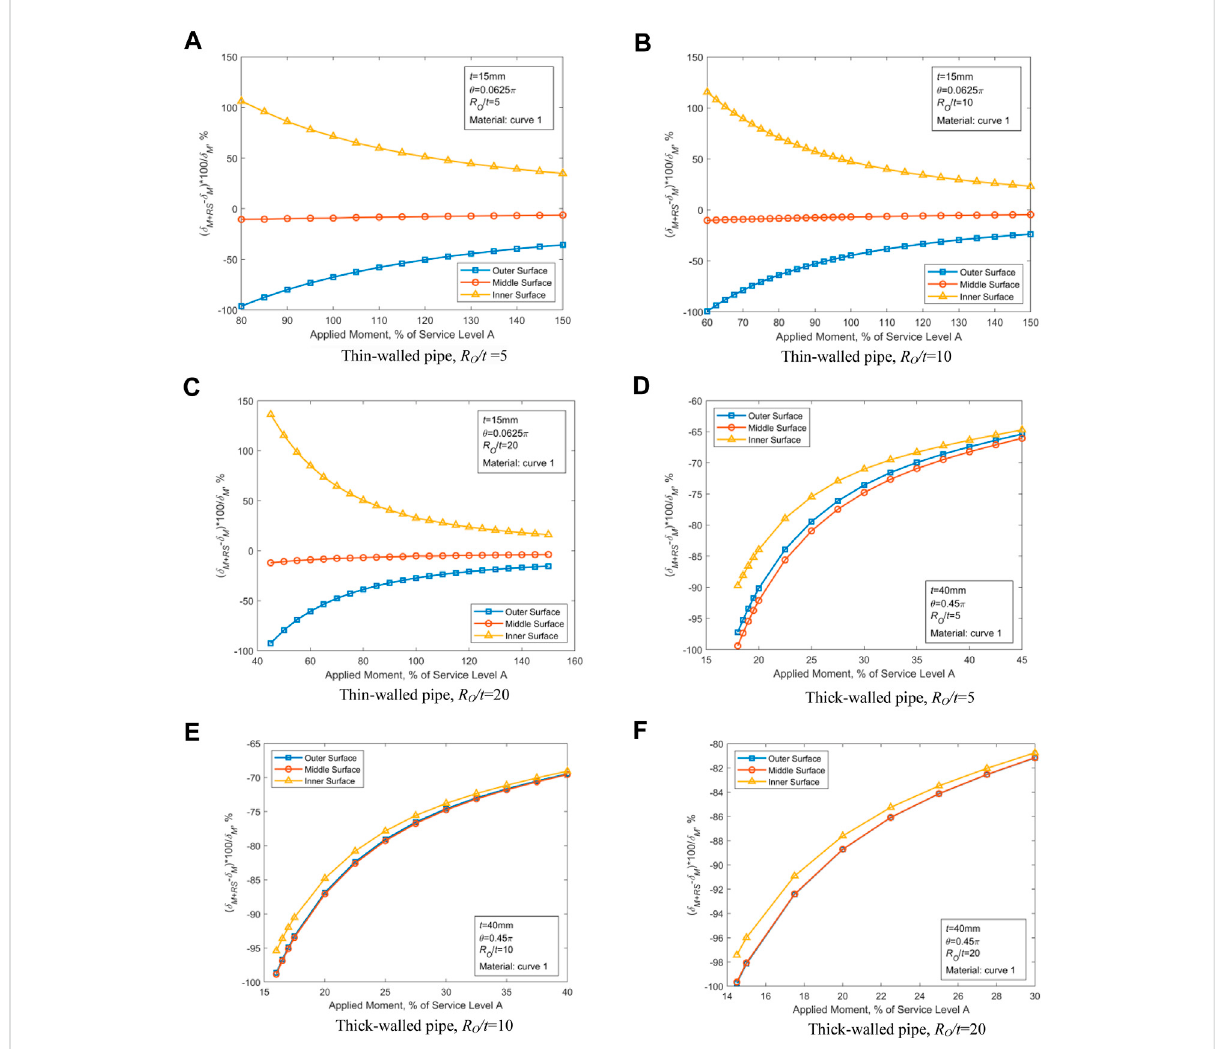
FIGURE 5 Effect of WRS on COD for R O /t = 5, 10, and 20 at different locations. (A) Thin-walled pipe, R O /t = 5. (B) Thin-walled pipe, R O /t = 10. (C) Thin- walled pipe, R O /t = 20. (D) Thick-walled pipe, R O /t = 5. (E) Thick-walled pipe, R O /t = 10. (F) Thick-walled pipe, R O /t =